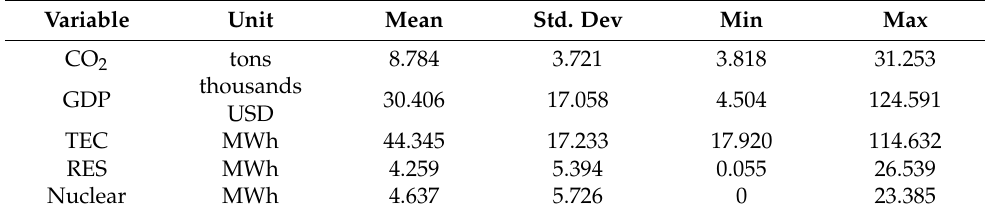
Table 1. Descriptive statistics of investigated